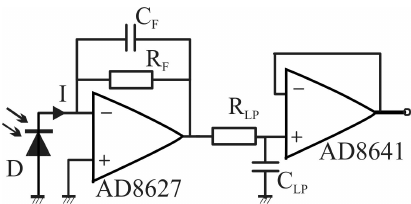
Figure 3. Detection electronics (one channel of two). D—photodiode. Further explanations in the text.